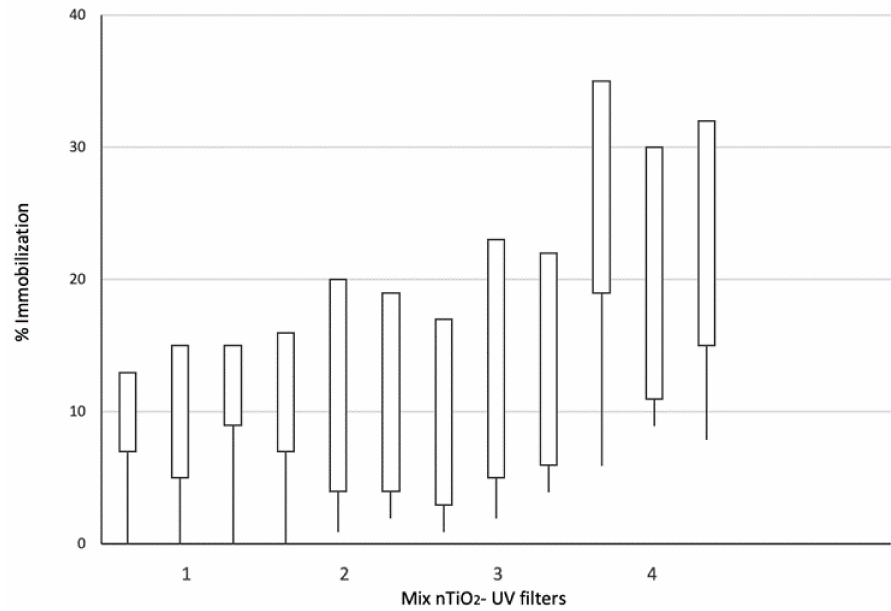
Figure 4. Artemia sp. exposed to a combination of nTiO 2 and mixtures of UV organic filters, BP3, OC, and EtPABA and 16 h of SSR. The chart shows the increment of the immobilization in the three replicates per